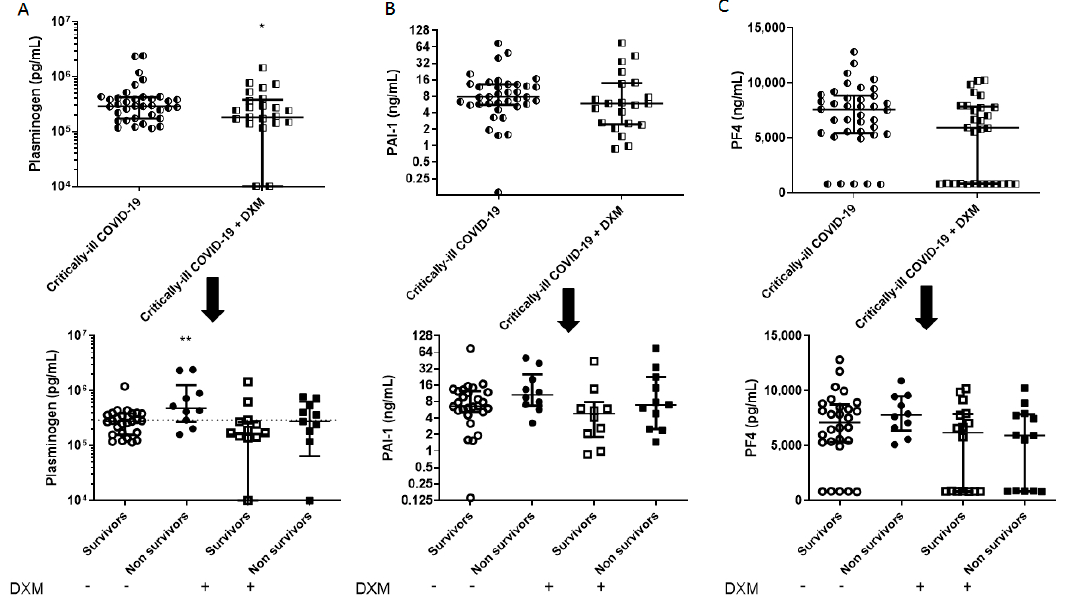
Figure 2. Intensive care unit (ICU) admission levels of coagulation biomarkers in COVID-19 patients. ( A ) Plasminogen, ( B ) PAI-1, and ( C ) PF4 were measured in 37 dexamethasone-free and 29 dexamethasone-treated (first dose—6 mg) critically ill patients upon ICU admission (within 24 h) (upper panels). The two patient groups were subsequently categorized as survivors and non-survivors (lower panels). Two-group comparisons were performed with the non-parametric Mann– Whitney test, * p < 0.05, ** p < 0.01. Data are presented as scatter plots, indicating the median value and 25 to 75 centiles. Dashed line, median value of the dexamethasone-free group. DXM = Dexamethasone; PAI-1 = Plasminogen activator inhibitor-1; PF4 = Platelet factor 4.